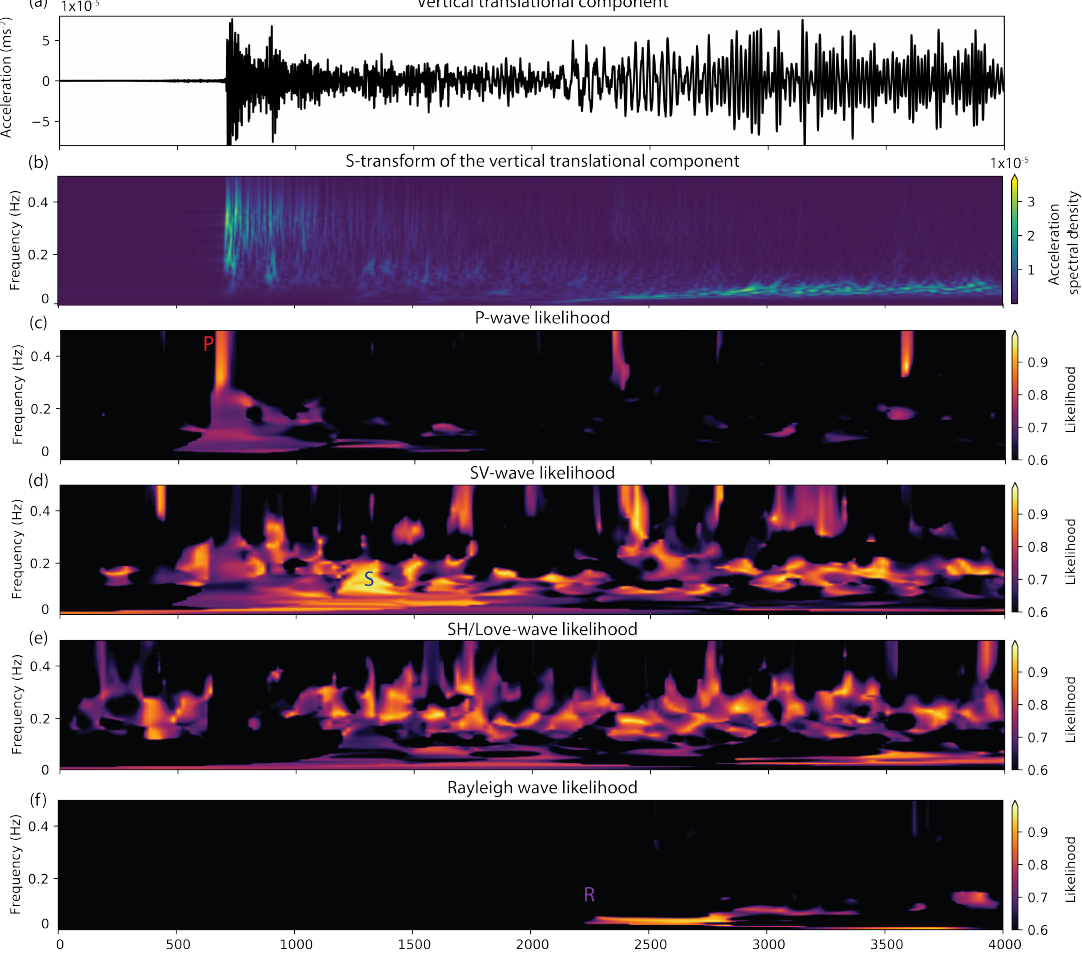
Figure 5. Automated wave type classification using 6DOF polarization analysis. High likelihood values indicate where the 6DOF polarization template for a specific wave type matches the polarization present in the data. Since the 6DOF polarization templates are unique for each wave type, this enables the automatic classification of different phases using just a single 6DOF recording. The vertical component translational seismogram and its S-transform are shown in ( a , b ). Likelihood values obtained from 6DOF analysis are shown in ( c ) for P-waves, ( d ) for SV-waves, ( e ) for SH/Love-waves, and ( f ) for Rayleigh